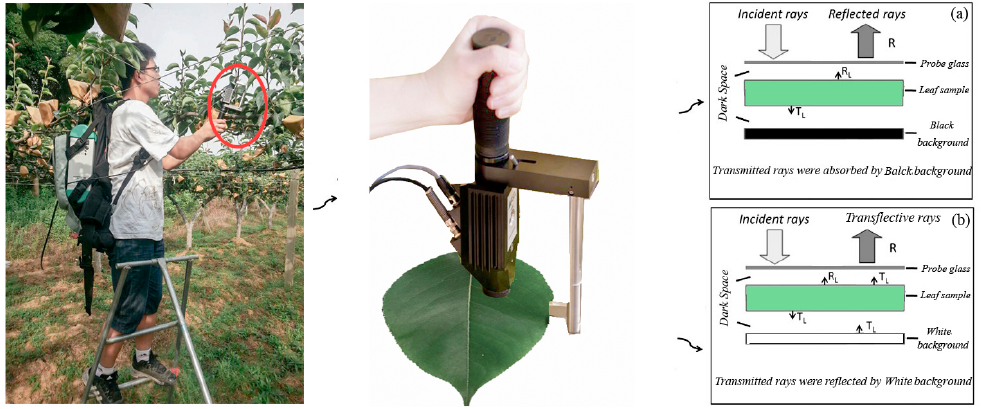
Figure 1. The schematic diagram of spectral acquisition by two methods. The reflectance measured with the black background ( a ); and the transflectance measured with the white background ( b ).